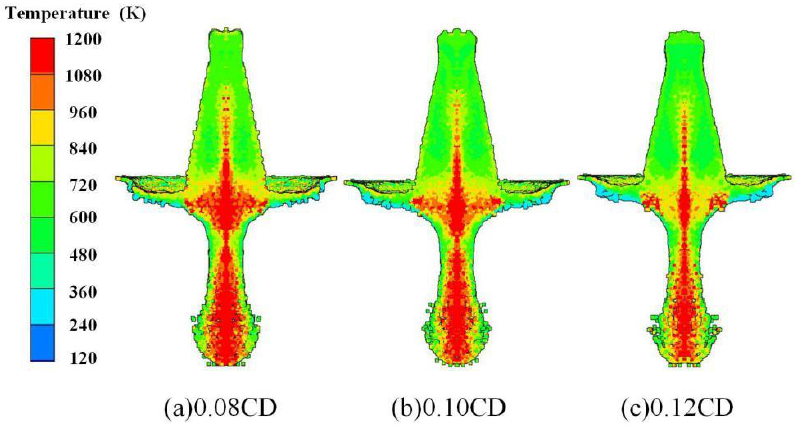
Figure 13. Reactive composite jet temperature distribution influenced by the wall thickness.